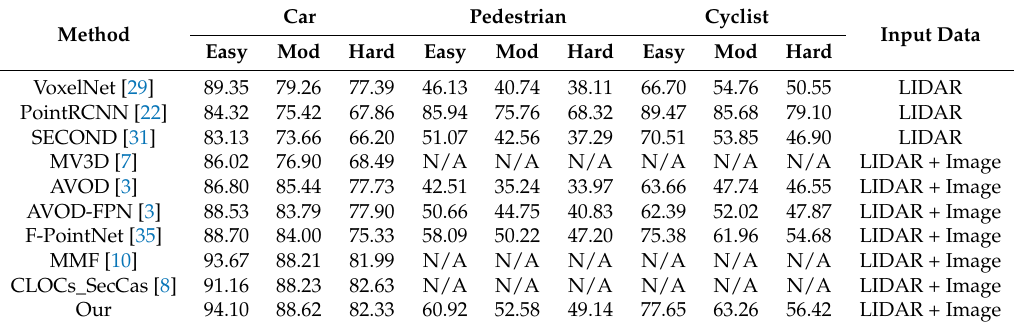
Our Table 7. Performance comparison with the compared methods on BEV object detection (AP, %) on KITTI test